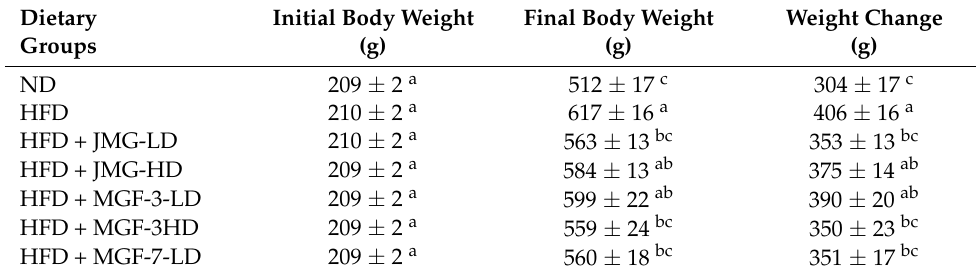
Table 1. Effects of Mei-Gin formulas on body weights, final body weight, and weight change in high-fat diet-induced obese